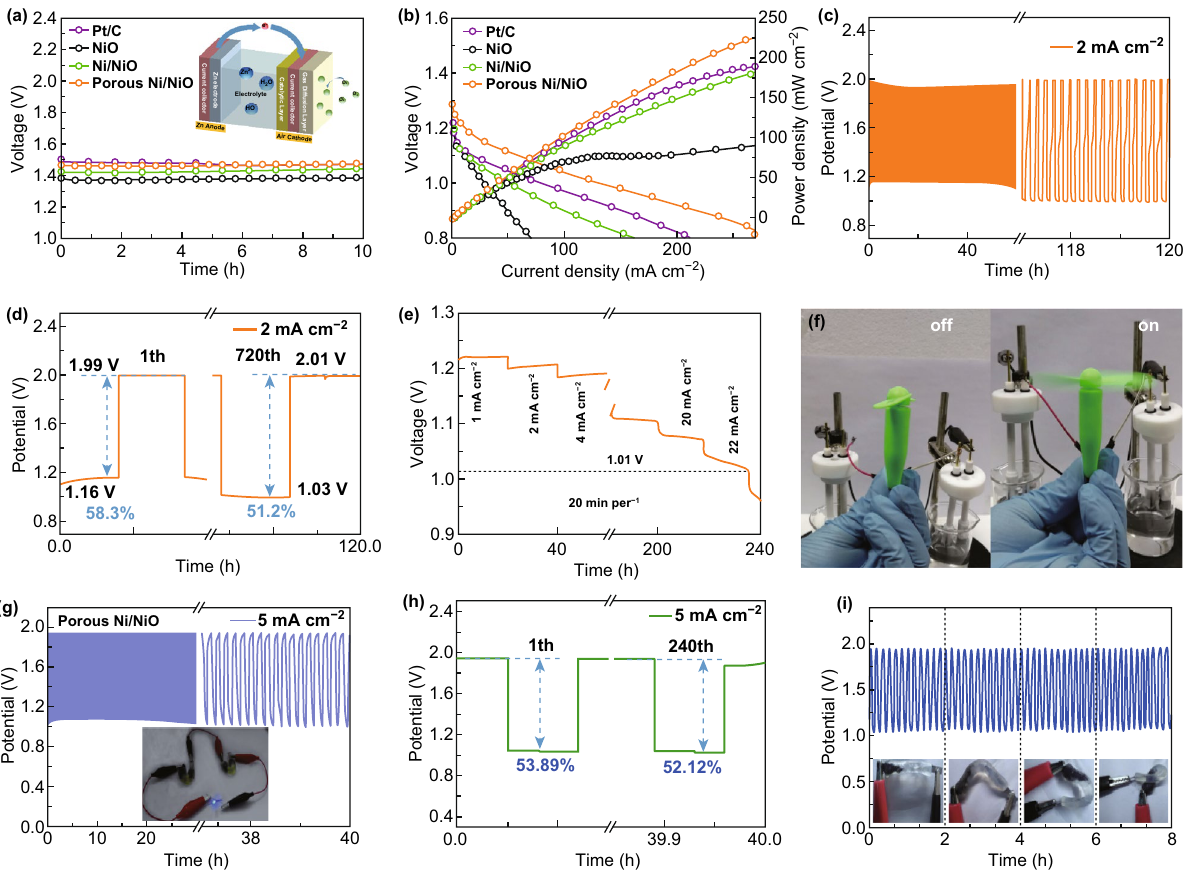
Fig. 5 a , b Open-circuit potential, discharge curves, and power density curves for Pt/C, NiO, Ni/NiO, and porous Ni/NiO. Inset shows sche- matic diagram for solution Zn–air battery. c , d Long-term discharge–charge cycling performance at 2 mA cm −2 for porous Ni/NiO-based battery. e Discharge curves of porous Ni/NiO-based battery at different current densities. f Air fan powered by two porous Ni/NiO-based Zn–air batter- ies in series. g , h Long-term discharge–charge cycling performance for solid-like Zn–air battery at 5 mA cm −2 , and i performance of porous Ni/ NiO-based battery under bending at different angles at 2-h